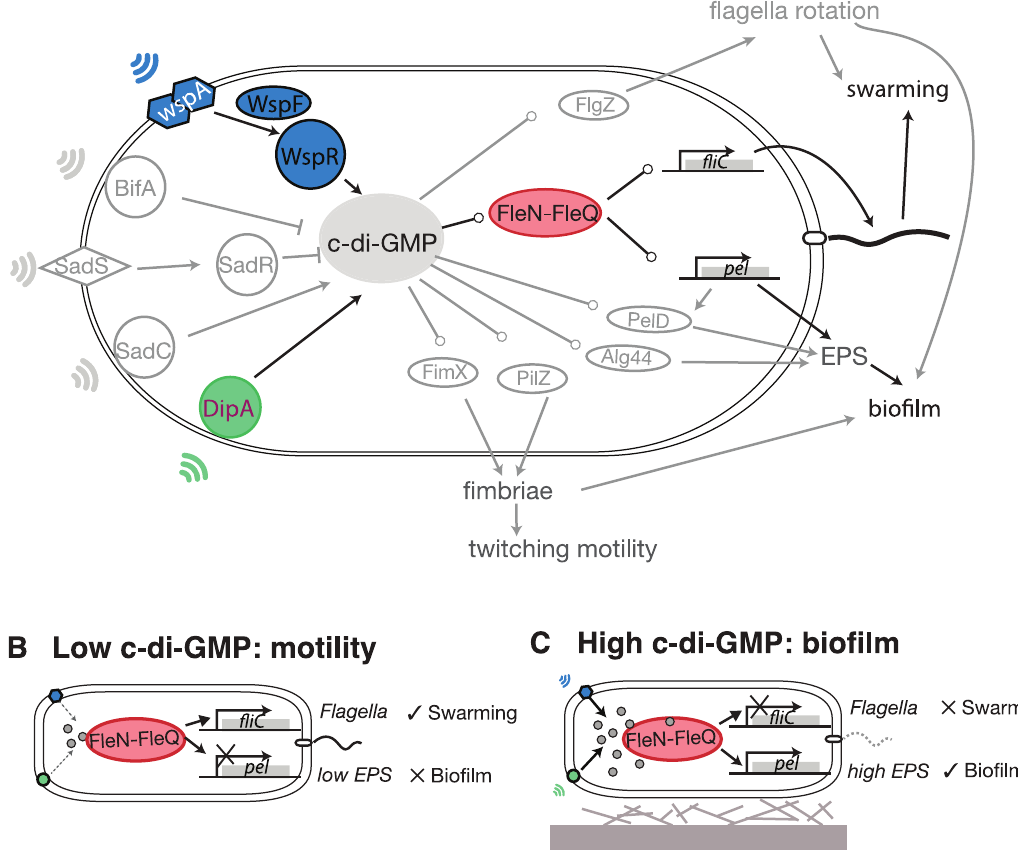
Fig 1. Bacteria integrate stimuli from the environment and decide whether to make biofilms or to move using the c-di-GMP network. A: Bow-tie architecture of c-di-GMP signalingnetwork: c-di-GMP is synthesized by diguanylate cyclase (DGC) proteins with GGDEF domainssuch as WspR, DipA, and SadC, and degradedby phosphodiesterases (PDE) proteins with EAL or HD-GYP domainssuch as BifA, and SadR. The DGCs and PDEs could sense stimuli—suchas chemoattractants which could be a signal for motility, or mechanical contact with surfaces which could be a signal for biofilm formation—and change intracellular c-di-GMP levels in response; c-di-GMP effectors—such as c-di-GMP binding proteinsand riboswitchRNAs—then sense c-di-GMP levels and control phenotype outputs such as biofilm formation, motility, virulenceand cell division.B: At low levels of c-di-GMP the bacteria express flagellagenesand go into motile mode. C: At high levels of c-di-GMP the bacteria repress flagellagenes, express biofilm genesand go into biofilm mode.